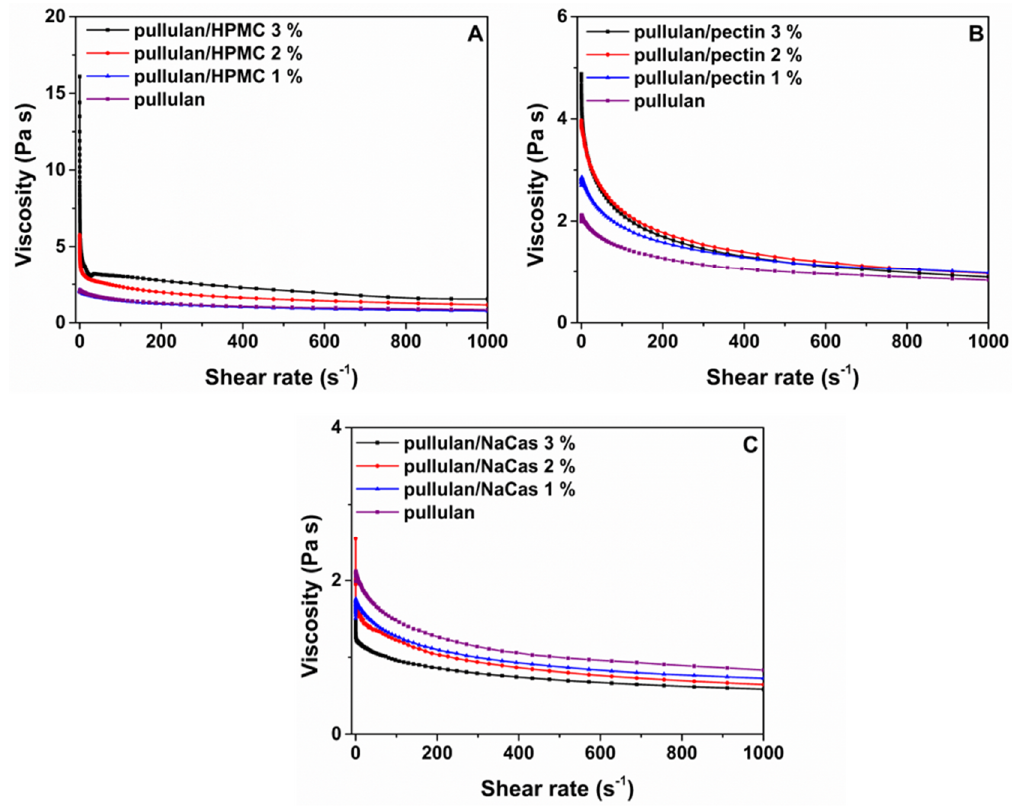
Figure 1. Viscosity as a function of shear rate for the pullulan solution and its blends with increasing concentrations of ( A ) HPMC, ( B ) pectin and ( C ) sodium caseinate.